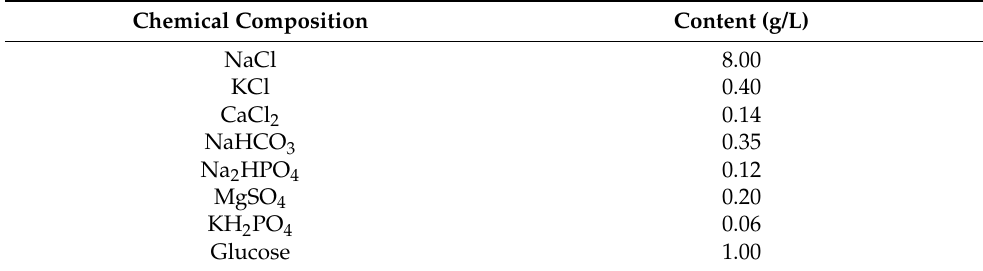
Table 2. Chemical compositions of Hank’s solution. Chemical